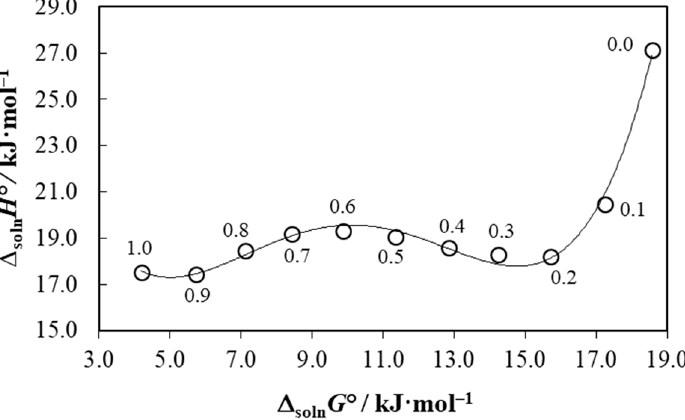
Figure 4. ∆ soln H ◦ vs. ∆ soln G ◦ enthalpy–entropy compensation plot for dissolution processes of Figure 4. ∆ soln H ° vs. ∆ soln G ° enthalpy–entropy compensation plot for dissolution processes of benzoic benzoic acid (3) in {ethanol (1) + water (2)} mixtures at T = 298.15 acid (3) in {ethanol (1) + water (2)} mixtures at T = 298.15 K.